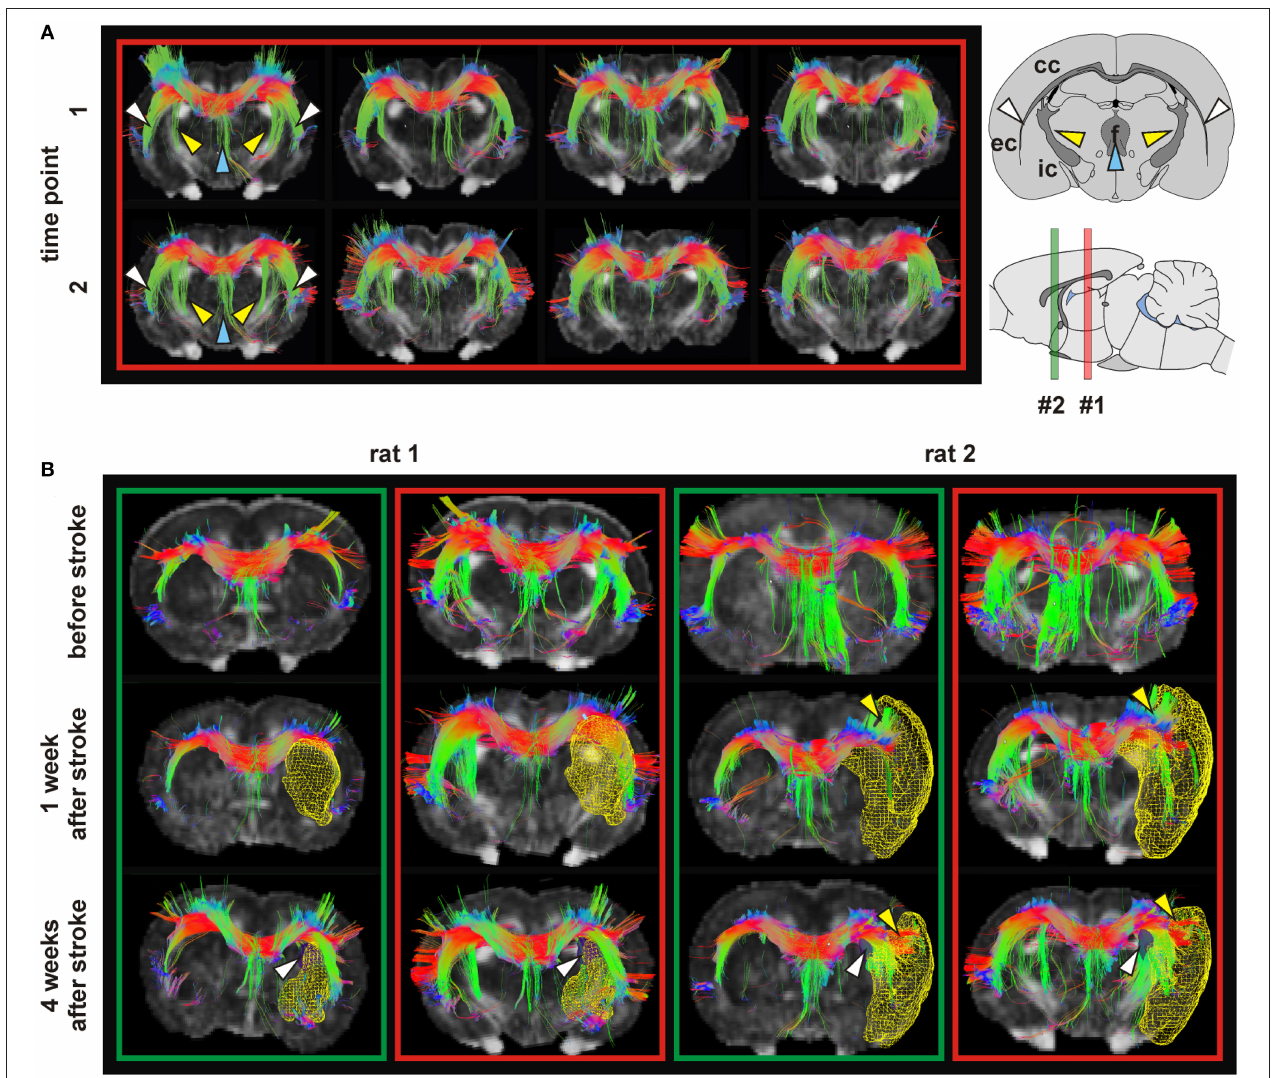
FIGURE 5 | Tractography in healthy and ischemic conditions. (A) Tractography of four healthy rat brains (columns) with corpus callosum (CC) as seeding area at two time points (t1, t2) 4 weeks apart. In all cases, the fibers of the CC followed the white matter through the internal capsule (IC) (yellow arrows), external capsule (EC) (white arrows) and fornix (blue arrows). (B) Tractography in two rats before stroke, and 1 and 4 weeks after stroke. In the green boxes, the reference slice is close to bregma, corresponding to slice #2 on the sagittal scheme. For the red boxes the reference section is more caudal, indicated by position #1 on the scheme. Lesion volumes (determined from T2-weighted MRI) are depicted as yellow mesh. Rat 1 developed a stroke in the caudate putamen (CPu), and rat 2 in the CPu and cortex. At 4 weeks post stroke, a modification of the connection between CC and IC (white arrows) is seen. In rats with stroke in CPu and cortex (rat 2) an extension of the CC into the cortex separating the infarct area and the rest of the cortex (yellow arrows) was observed. Figures show color coded tracts in the horizontal (red), vertical (green) and transversal (blue) direction, indicated in the arrow schematic at top right. Reproduced with permission from Po et al.